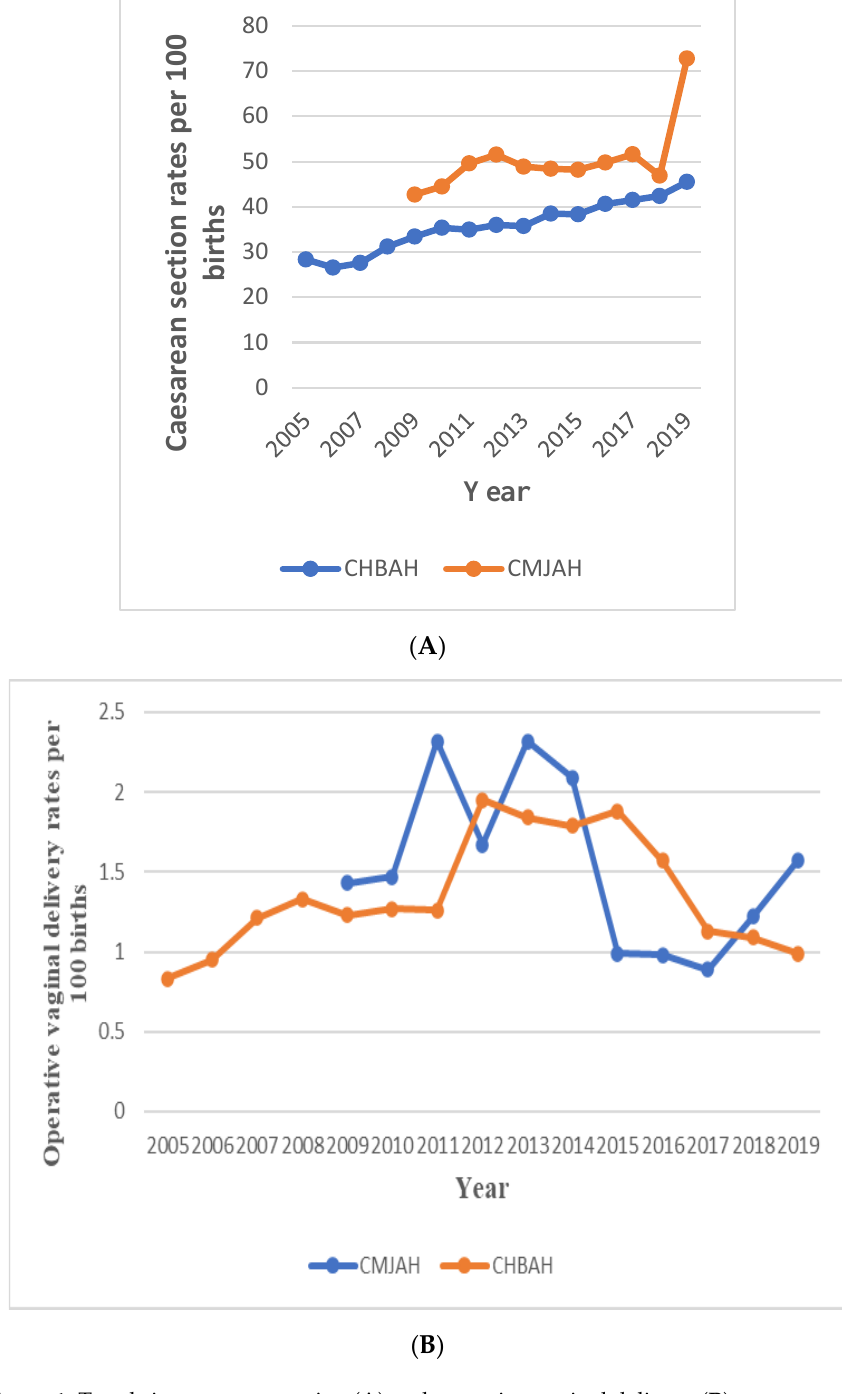
Figure 1. Trends in caesarean section ( A ) and operative vaginal delivery ( B ). Table 1. Join point regression of the trends in the caesarean section and operative vaginal deliveries at two academic hospitals in Johannesburg (2005 – 2019).